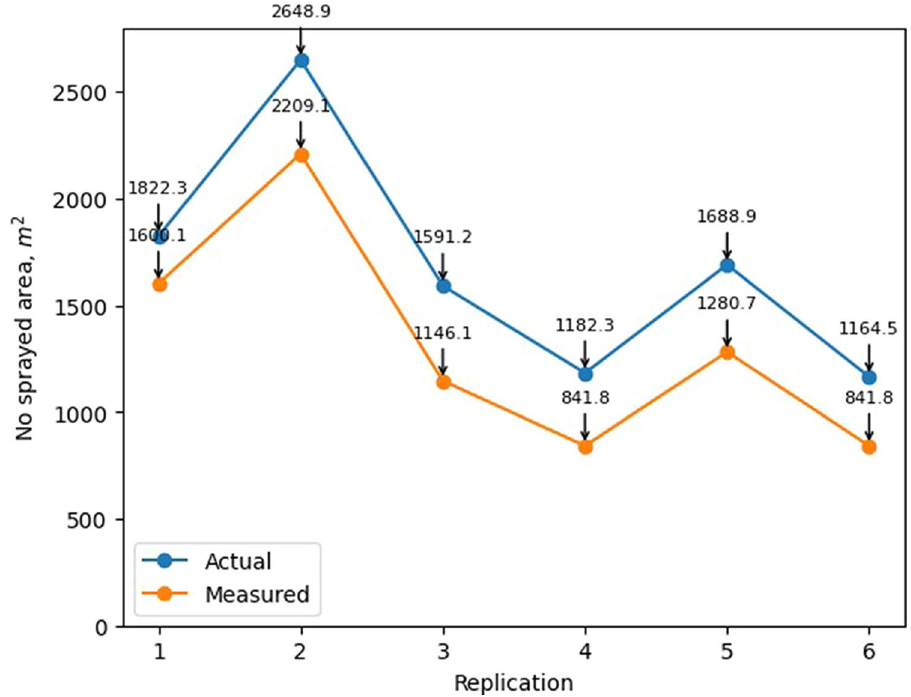
Figure 8. Comparison of the land area, in m 2 , between the prescription map uploaded to the sprayer (Actual) and area covered a during application (Measured) across the six replications for the site-specific weed control treatment.